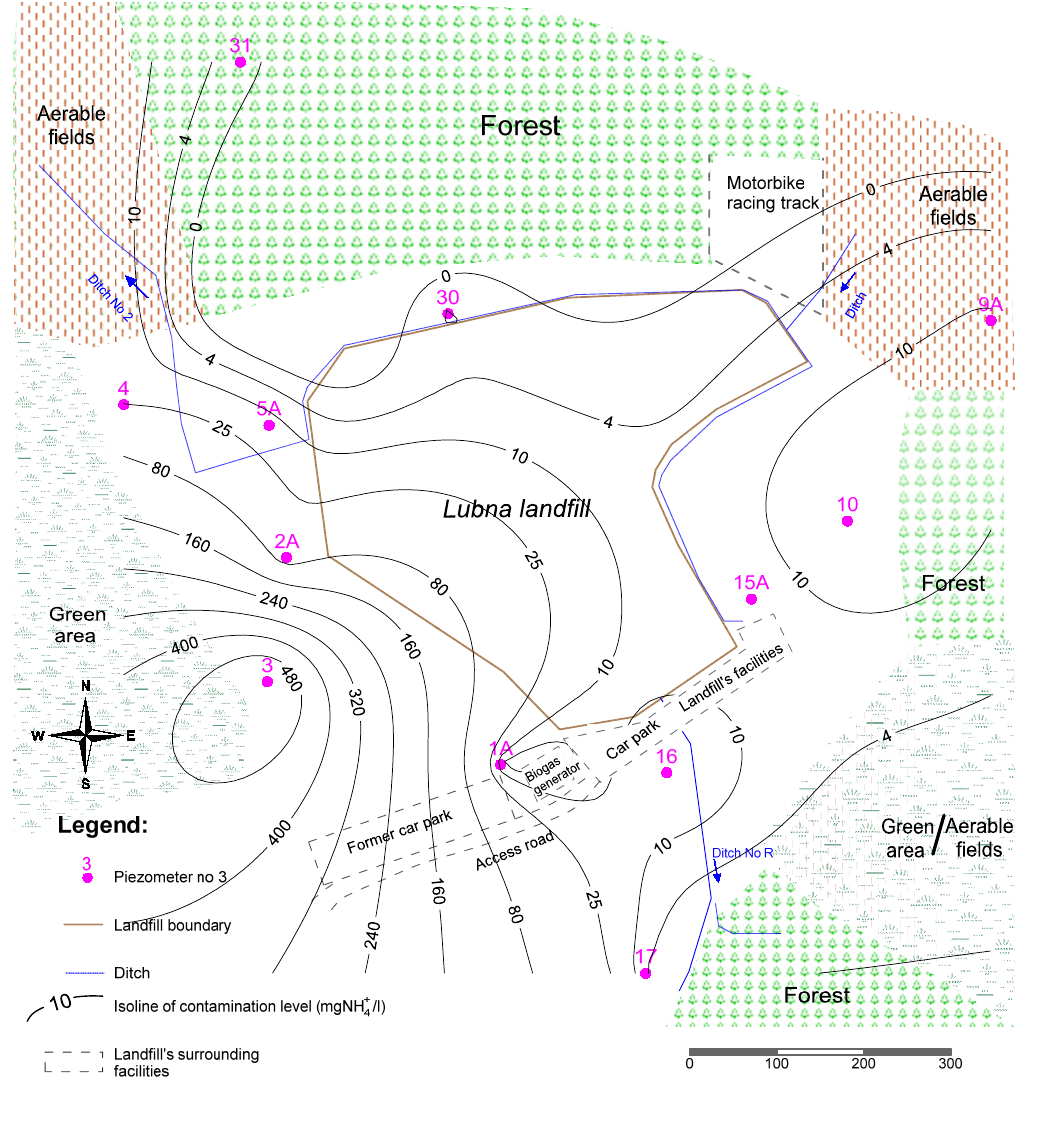
Figure 8. Distribution map of ammonium contamination within Lubna Landfill surroundings (1996), before vertical barrier